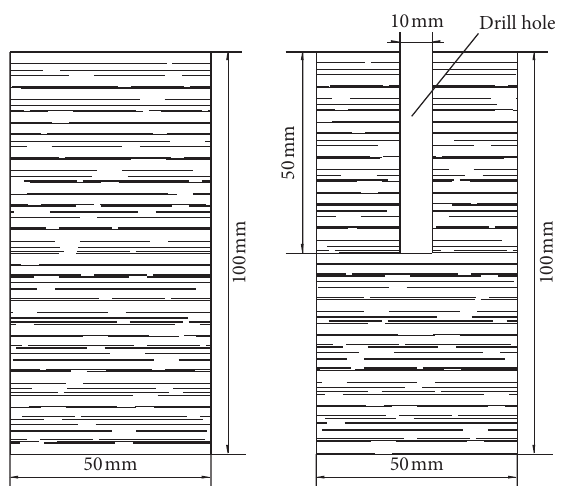
Figure 1: Conventional coal sample and porous coal